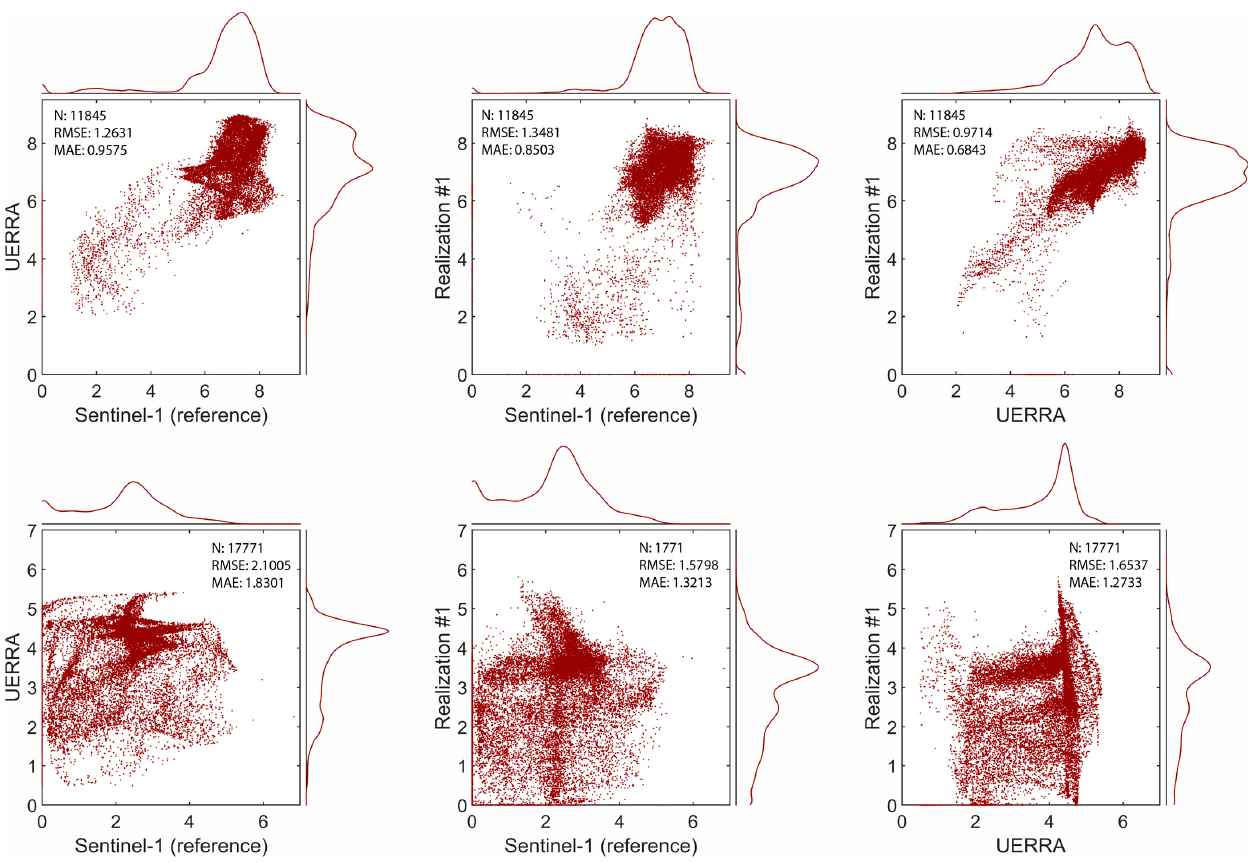
Figure 7. Scatterplots and marginal distributions between wind speed values (m/s) from UERRA, Sentinel-1 (reference) and one realization each on 10 June 2017 (first row) and 15 June 2017 (second